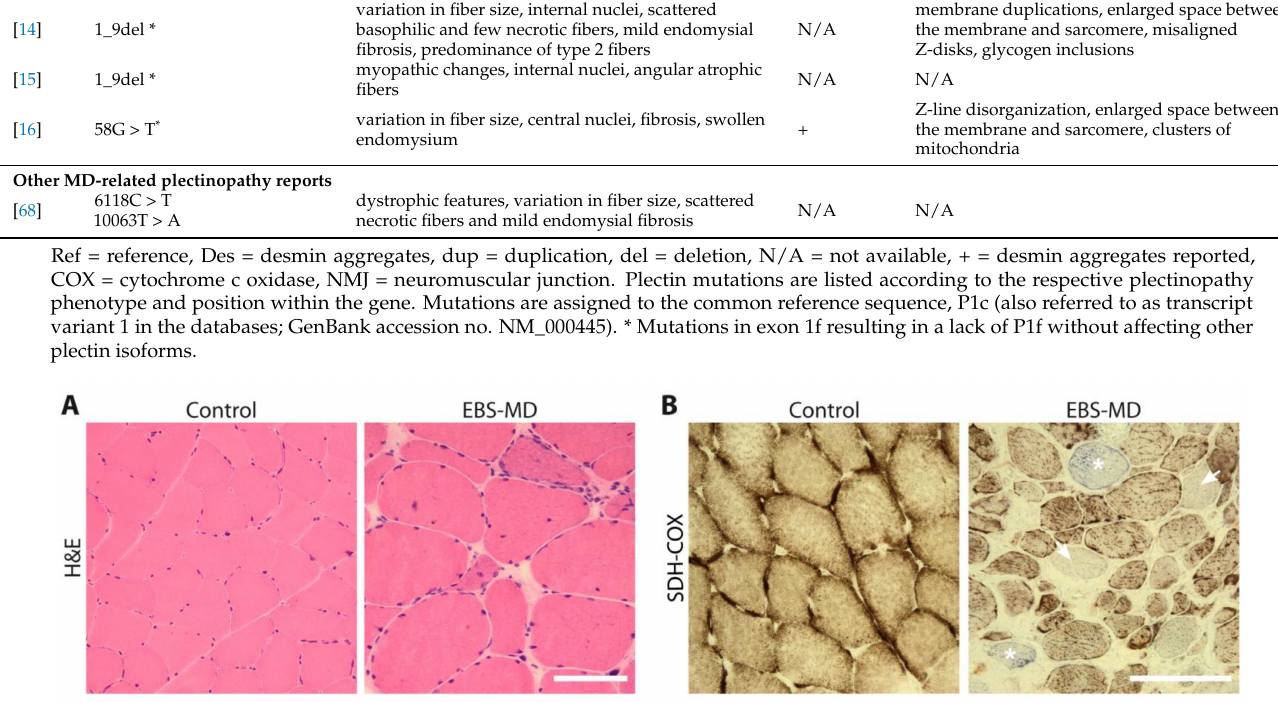
Figure 2. Skeletal muscle pathology in epidermolysis bullosa simplex with muscular dystrophy (EBS-MD). ( A ) Skeletal muscle sections from a healthy control and a patient suffering from EBS-MD were stained with hematoxylin/eosin (H&E). Note the rounding of the muscle fibers, the marked variation in the fiber size, the increased amounts of connective tissue and fat cells, and the clustering as well as the centralization of the myonuclei in the EBS-MD patient muscle biopsy sample. ( B ) Succinate dehydrogenase and cytochrome c oxidase (SDH-COX) double-staining of skeletal muscle sections from a healthy control and a patient suffering from EBS-MD displays altered mitochondrial morphology, including the presence of rubbed-out areas (arrows) and COX-negative fibers (*) in the EBS-MD patient but not in the control sample. Scale bars: 100 µ m. (Images, courtesy of R.